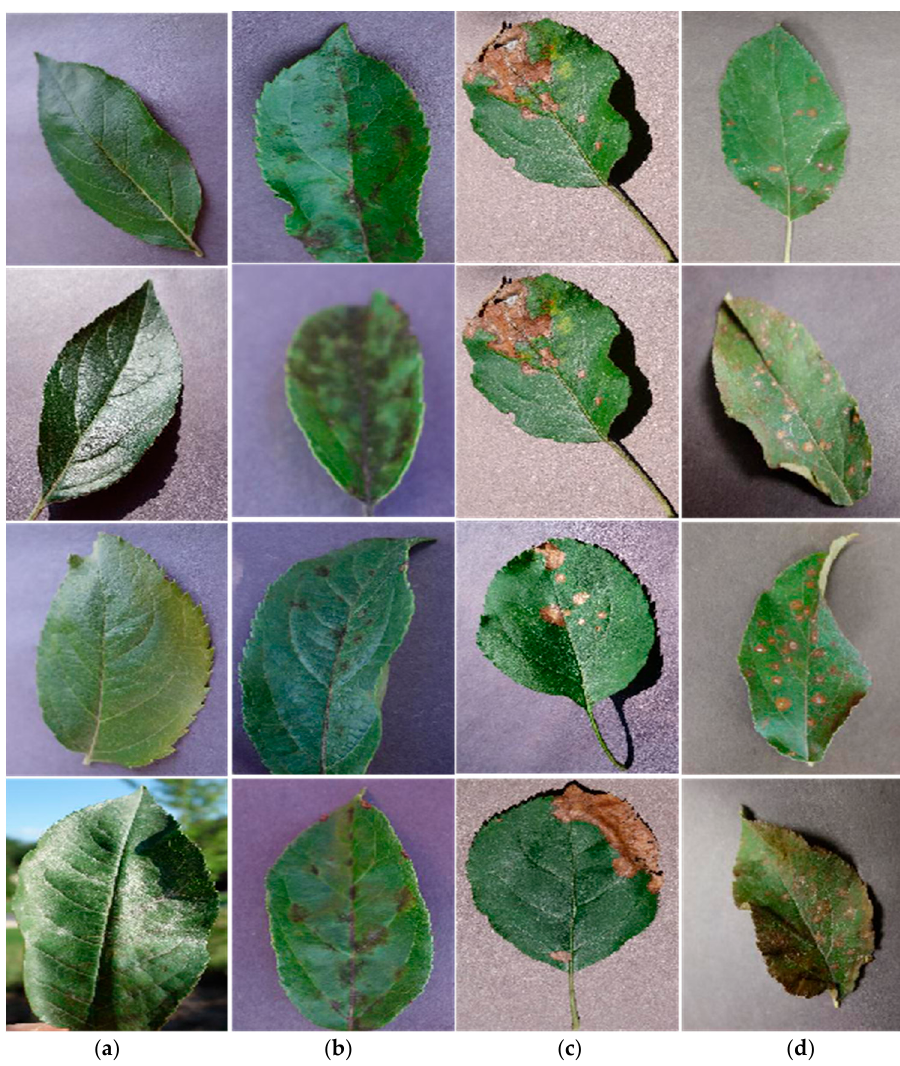
Figure 1. Four kinds of apple leaves. ( a ) Healthy, ( b ) scab, ( c ) frogeye spot, ( d ) cedar rust. Table 1. Details of the apple